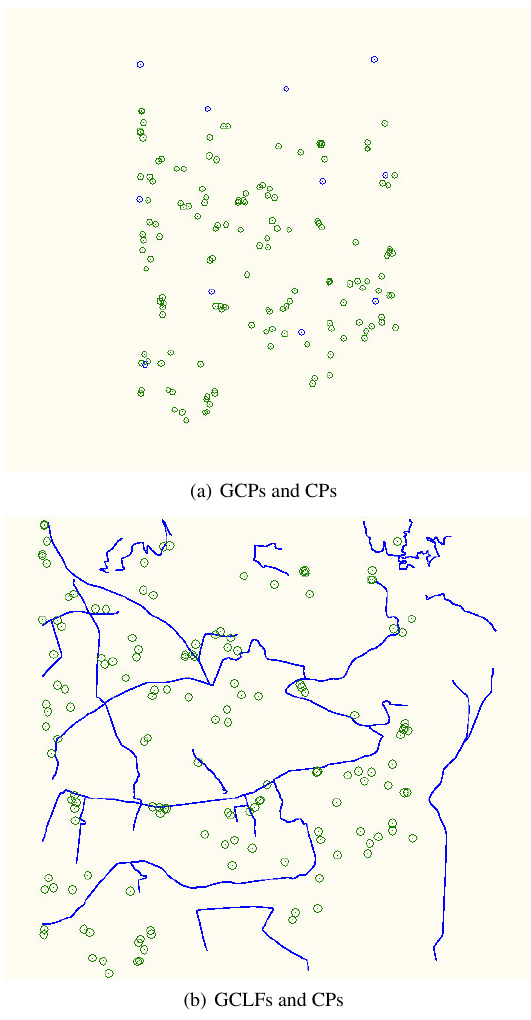
Figure 2: The distribution of the GCPs (in blue), the GCLFs (in blue) and the CPs (in green) over the test site.